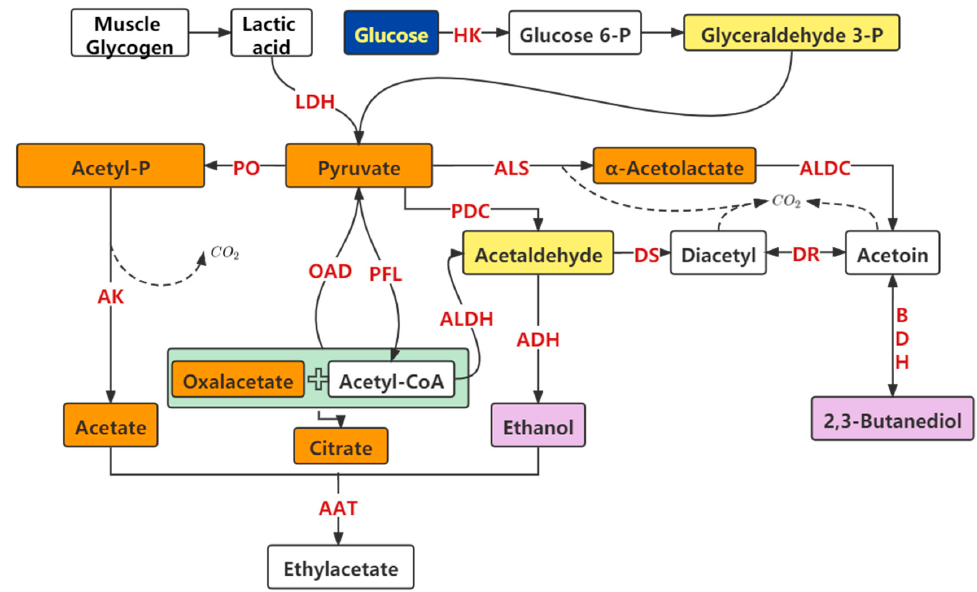
Figure 3. Metabolism of sugar substances by lactic acid bacteria and production of flavor substances. HK: hexokinase; LDH: lactate dehydrogenase; PO: pyruvate oxidase; ALS: acetolactate synthase;